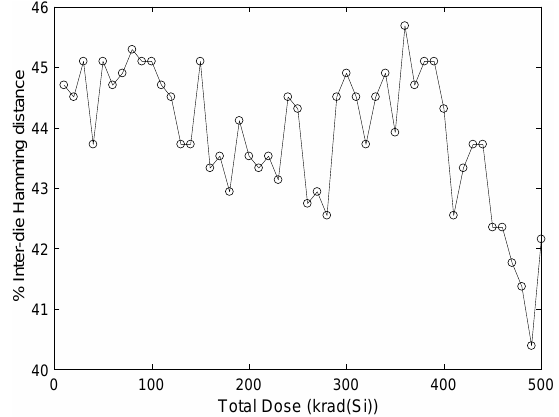
Figure 11. Uniqueness vs.